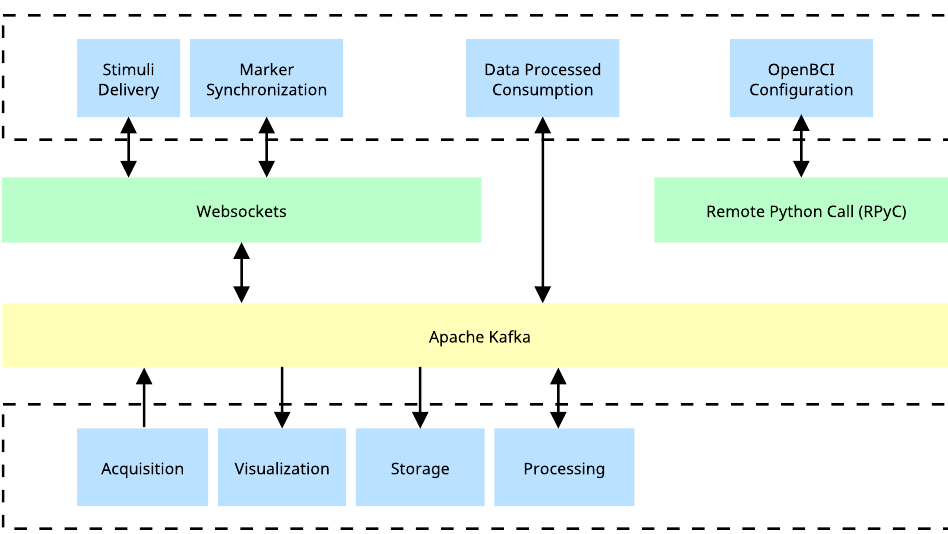
accurate measure requires feedback and comparisons.